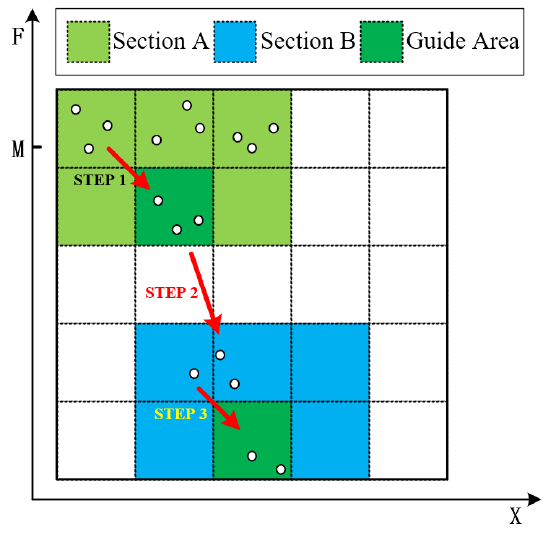
Figure 2. Individuals’ Distribution